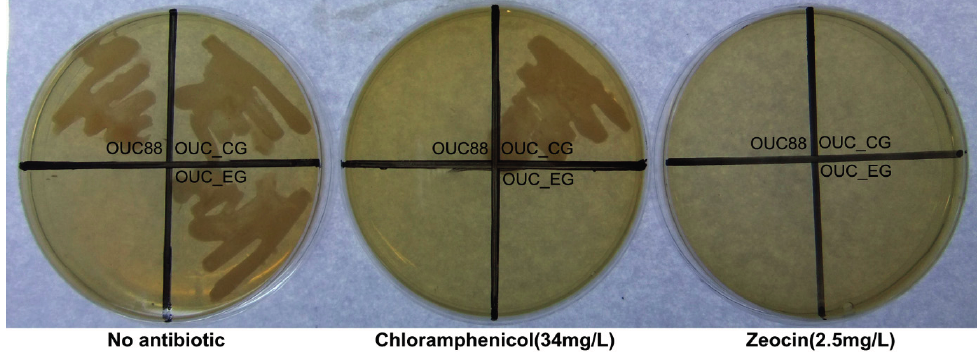
Figure 3. The growth of A. limacinum OUC88, A. limacinum OUC_CG and A. limacinum OUC_EG on different solid